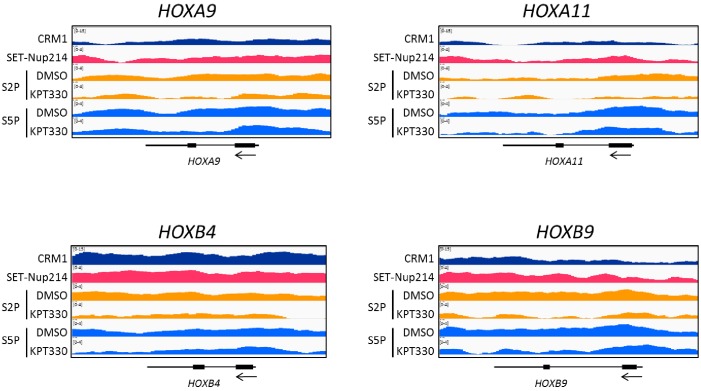
ChIP-seq profiles of CRM1, SET-Nup214, S2P (DMSO, KPT-330), S5P (DMSO, KPT-330) around HOXA9, HOXA11, HOXB4, and HOXB9 genes.